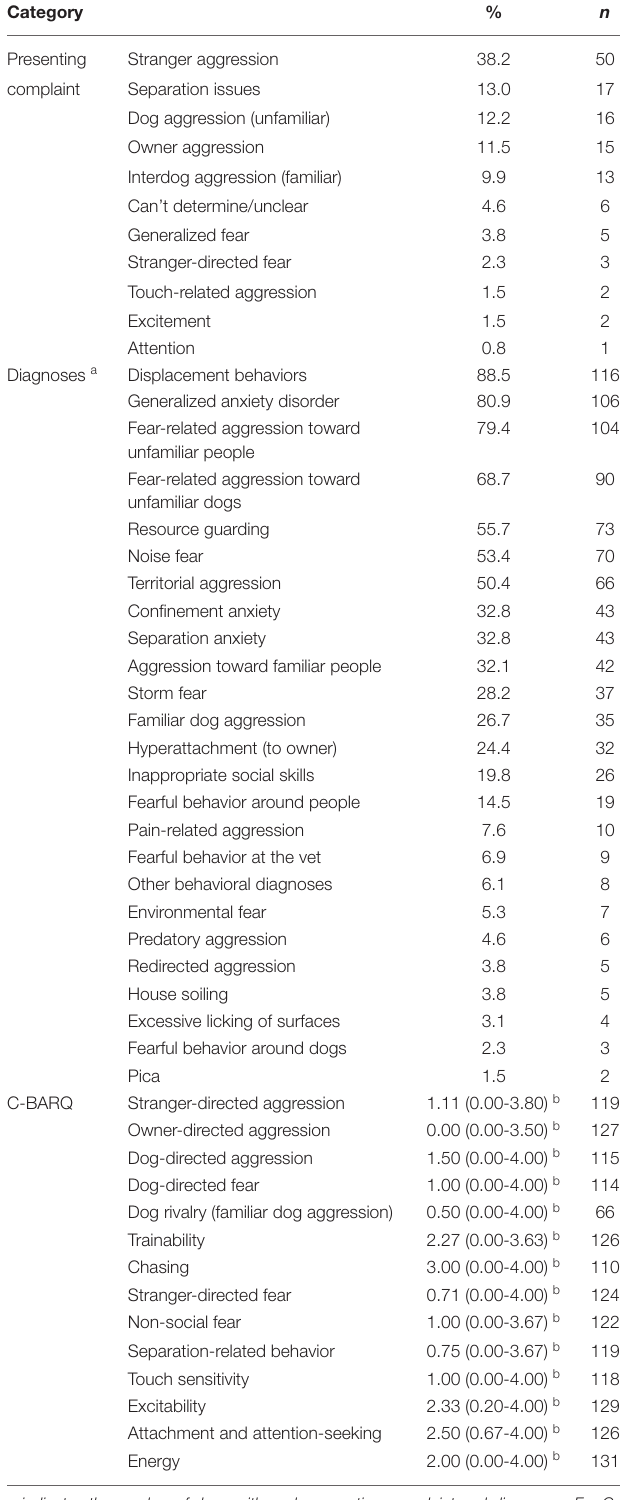
n indicates the number of dogs with each presenting complaint and diagnoses. For C- BARQdata,nshowsthenumberofdogswithvalidbaselinedataforthissubscale. a Dogs could have multiple behavioral diagnoses. b Data are presented as median